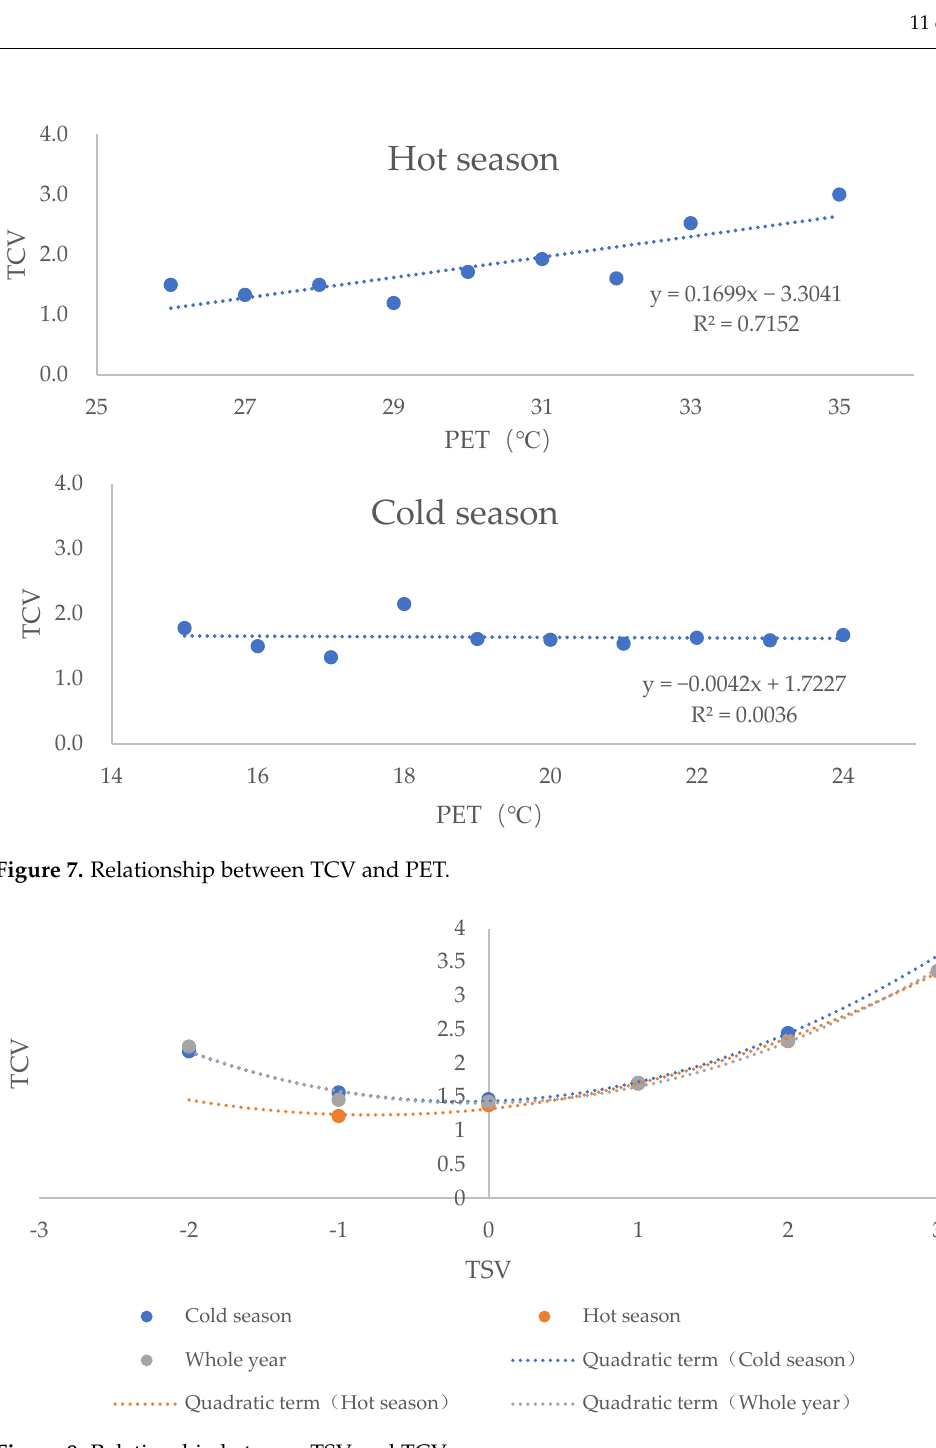
Figure 6. TCV frequency statistics.